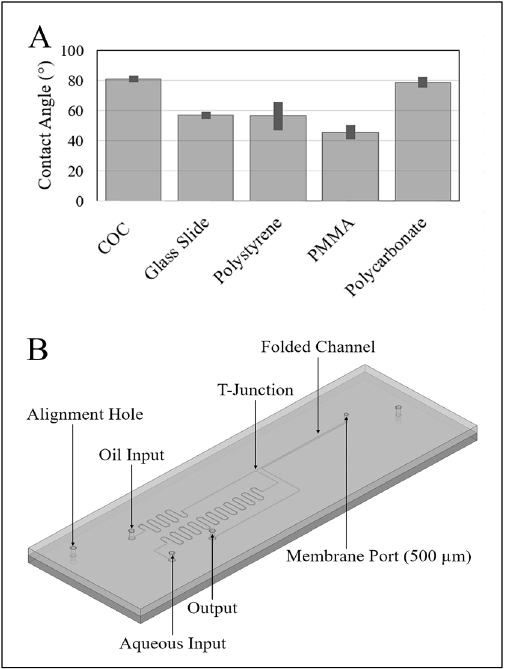
Figure 1. ( A ) Comparison of the water contact angle for potential device materials. Cyclic olefin copolymer (COC) and polycarbonate have the highest contact angle. COC is chosen for soft embossing performance. ( B ) Schematic of droplet delivery device. Note the oil and aqueous inputs, T-junction, and the membrane port.